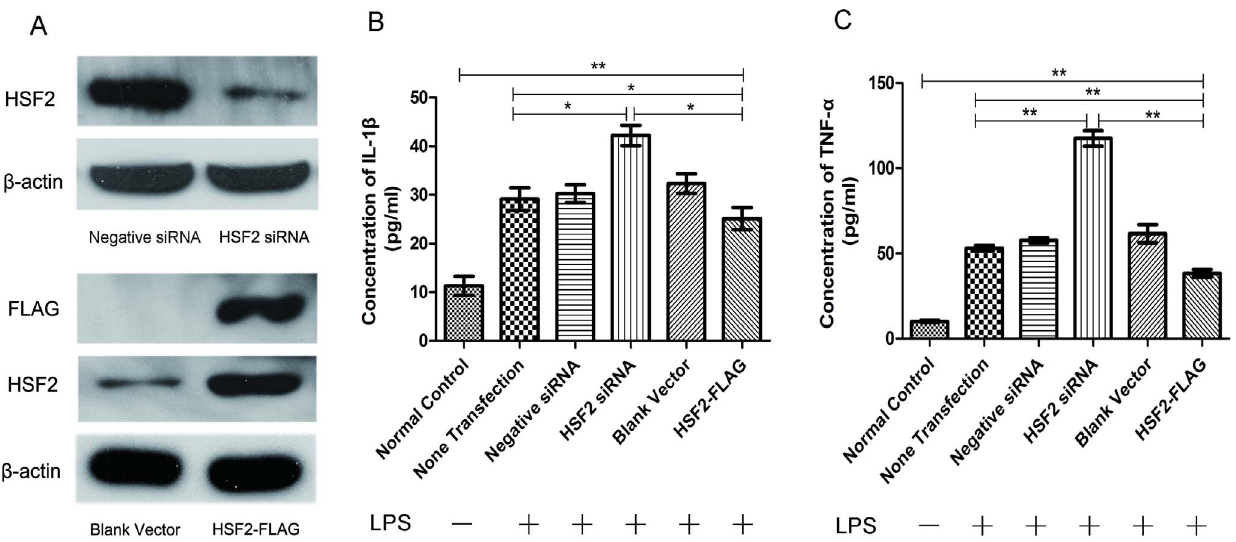
Figure 6. The secretion of IL-1 b and TNF- a in Caco-2 cells after enhanced expression or siRNA of HSF2. A: The HSF2 expression levels after HSF2 RNA interferenc and HSF2-FLAG recombinant plasmid transfection, b -actin as an endogenous control. B: The productions of IL-1 b in Caco- 2 cells supernates stimulated or not by LPS (50 ng/ml). C: The productions of TNF- a in Caco-2 cells supernates stimulated or not by LPS (50 ng/ml). *, p , 0.05;**, p ,